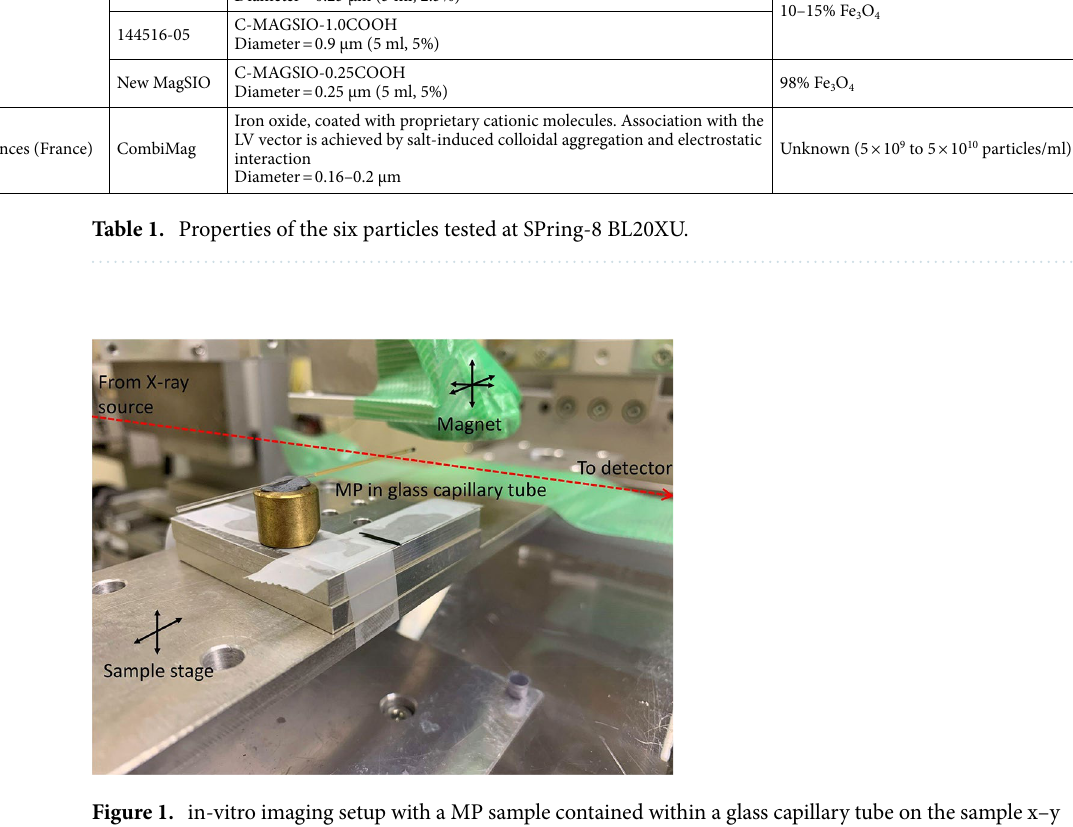
Figure 1. in-vitro imaging setup with a MP sample contained within a glass capillary tube on the sample x–y translation stage. The path of the X-ray beam is marked with a red dashed